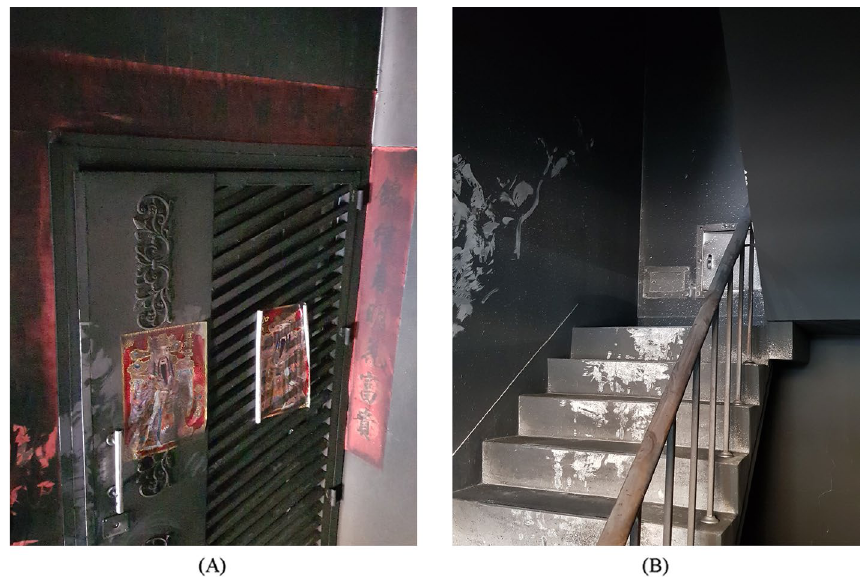
Figure 5. Description of the blackened stair ( A ) Doorway of residents on the third floor. ( B ) Steps of the stair on the third